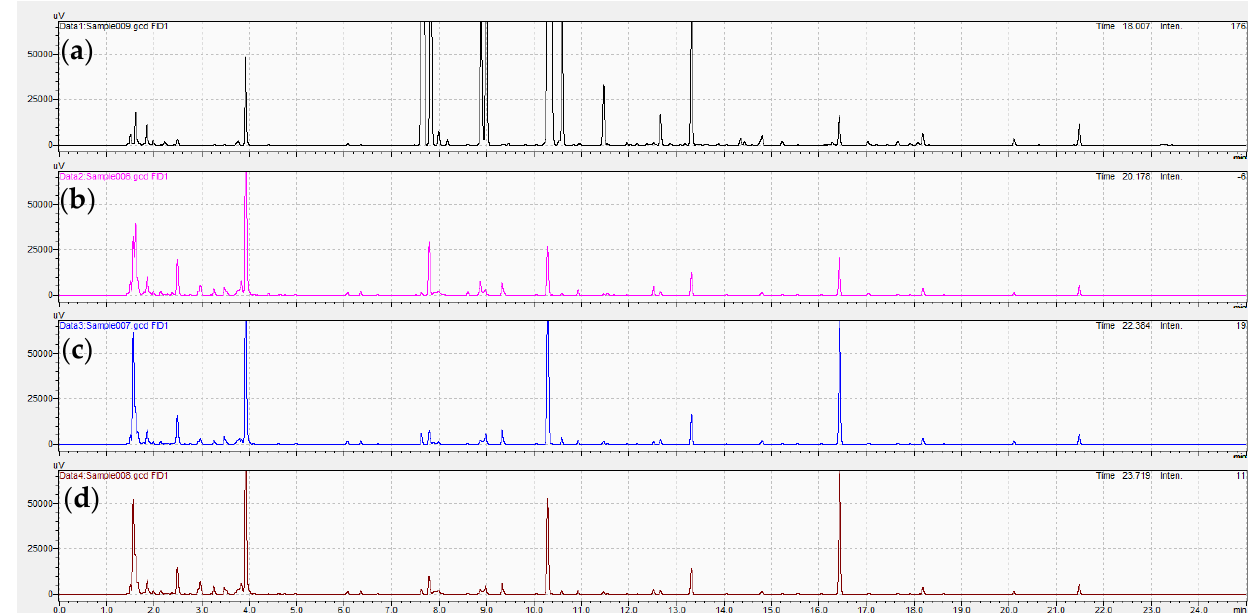
Figure 4. The GC chromatograms of black cumin seed oils obtained from ( a ) screw press machine and SCCO 2 extractions at 30.0 MPa ( b ) 40 °C, ( c ) 50 °C, and ( d ) 60 °C. The y-axis is normalized to the similar maximum intensity of 7.5 × 10 4 µV.